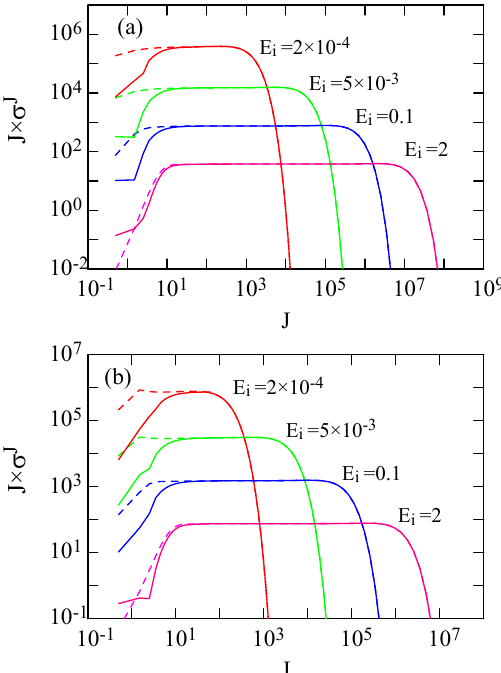
Figure 2. Variation of J × σ J with partial waves J for ( a ) 2p 1/2 –2s 1/2 and ( b ) 2s 1/2 –2p 3/2 transitions. Broken curves: Born and continuous curves: CC + Born results. Energies are in